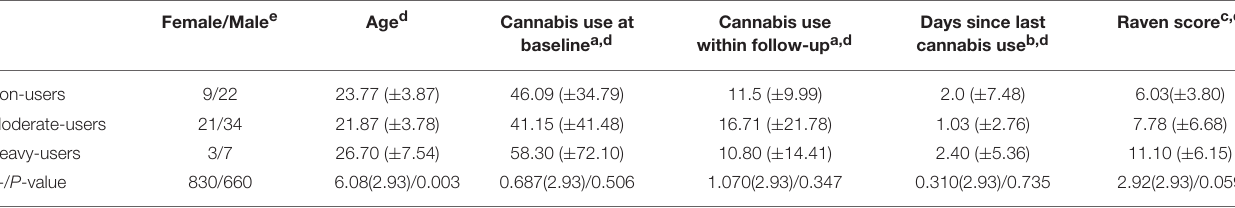
TABLE 1 | Group characteristics.